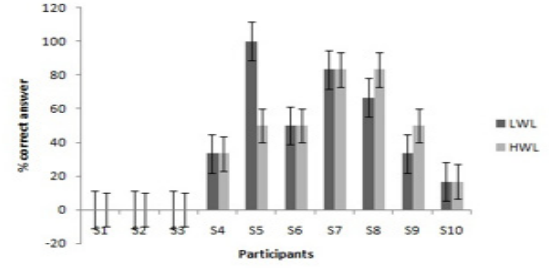
Figure 3. Percentage correct responses for system monitoring